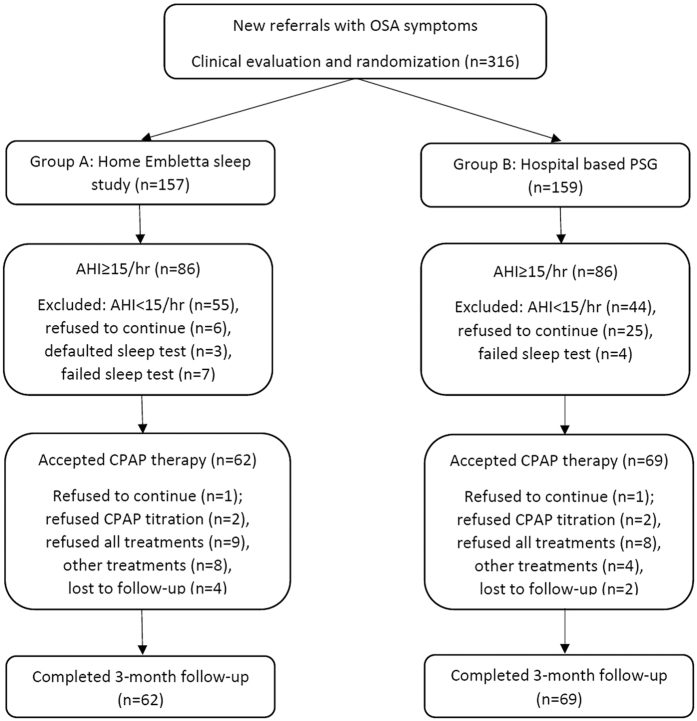
Consort diagram of participants randomized to the home-based versus hospital-based management pathways.Data were analysed on an intention-to-treat (ITT) basis comparing the two groups in terms of demographics, and waiting time for diagnostic tests, CPAP titration and treatment by including all patients randomized. Data were analysed on a modified ITT basis by including patients with AHI ≥ 15/hr starting fixed CPAP therapy in both groups whereas treatment per-protocol (TPP) analysis was conducted for those with AHI ≥ 15/hr who had completed the 3-month CPAP outcome study. * In group A with AHI ≥ 15/hr, 17 out of 86 patients failed the first home sleep test and had to undergo the second home sleep test which was successful. In group B with AHI ≥ 15/hr, 2 out of 86 patients had to undergo PSG twice. Seven out of 157 and 4 out of 159 in group A and group B “failed” sleep tests twice respectively due to either technical problems or poor sleep (total sleep time <0034 hrs) and the 7 patients in group A proceeded to PSG. # In group B, 25 patients refused to continue the study after randomization as the waiting time for polysomnography was too long.